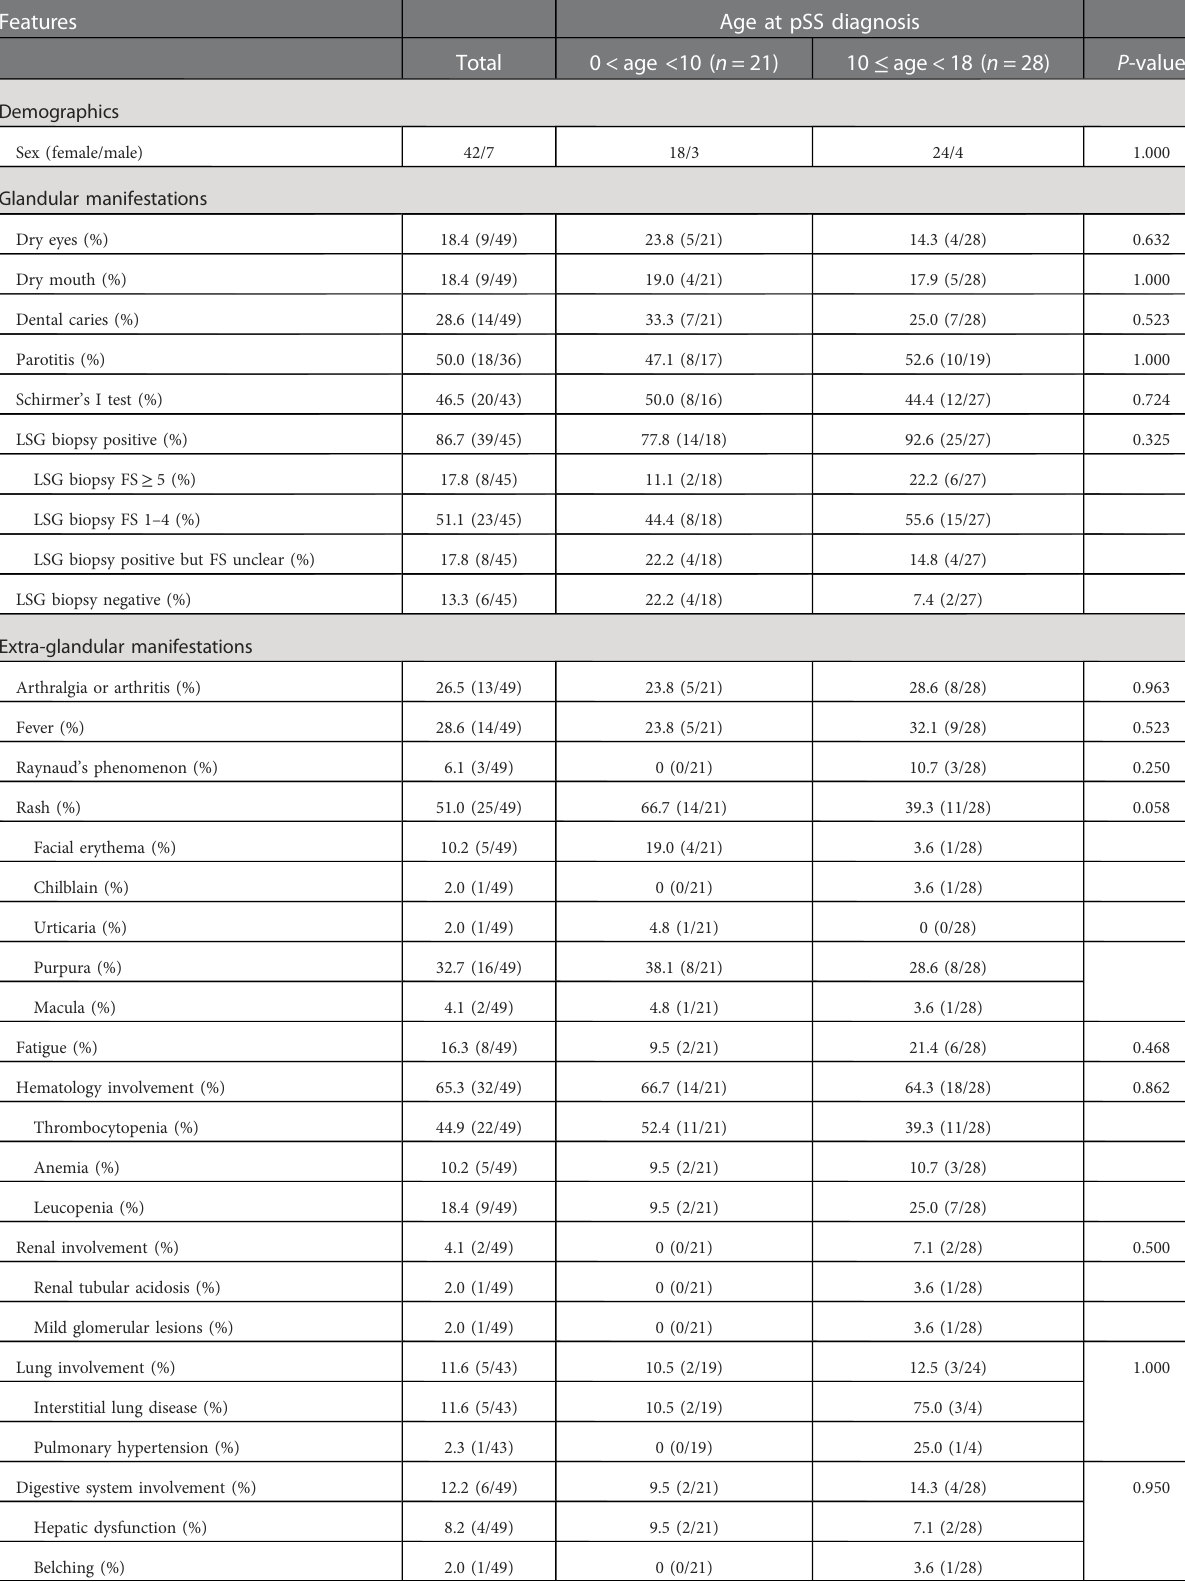
TABLE 1 Summary of clinical, laboratory, and histopathology features of childhood-onset pSS cohort ( n